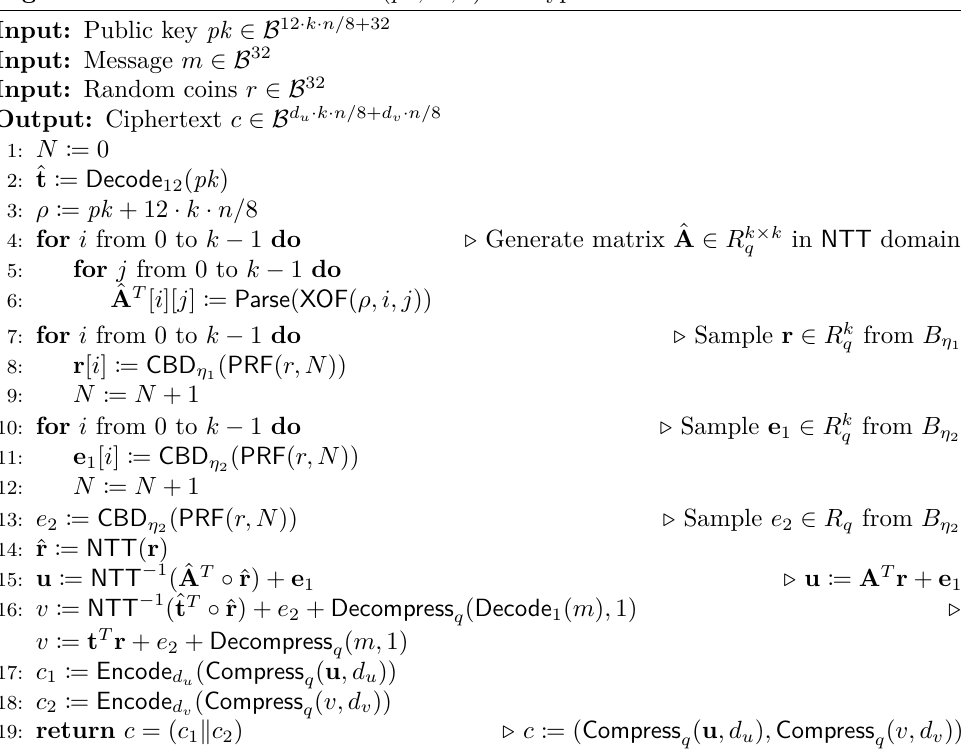
Algorithm 5 Kyber . CPAPKE . Enc ( pk , m, r ):